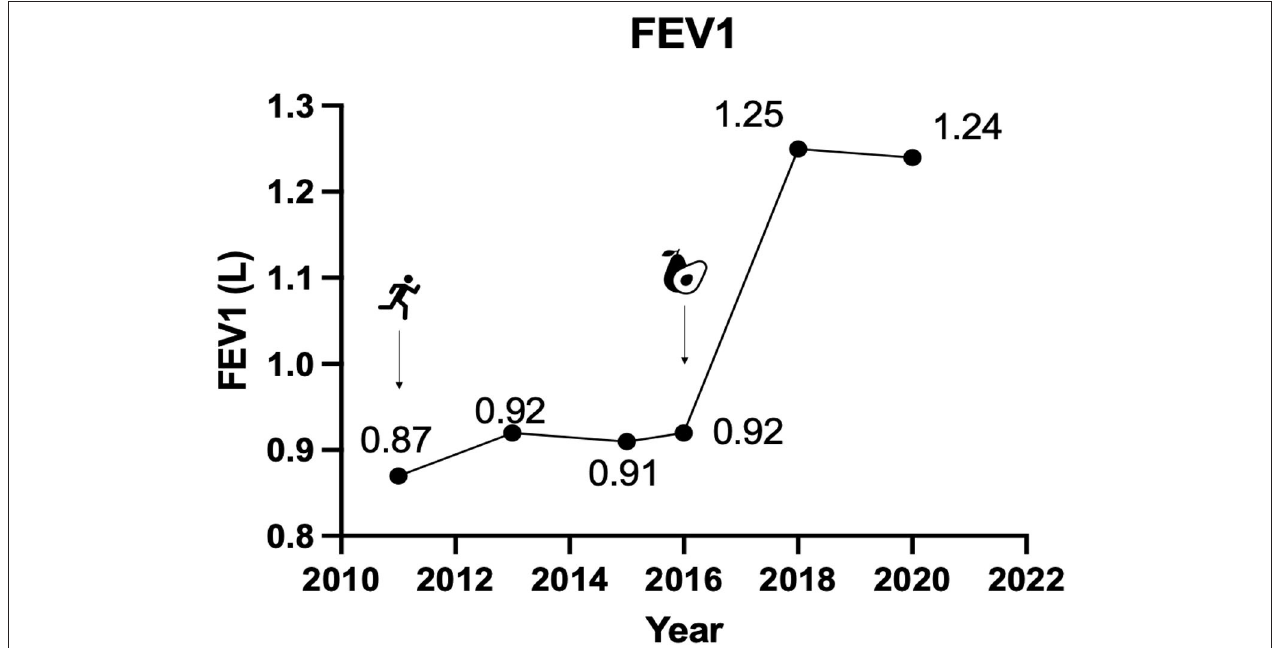
FIGURE 2 | Forced expiratory volume in 1s. Data represent C.A.’s FEV1 at four time points prior to starting a ketogenic diet and at two time points, 2019 and 2020, after commencing the